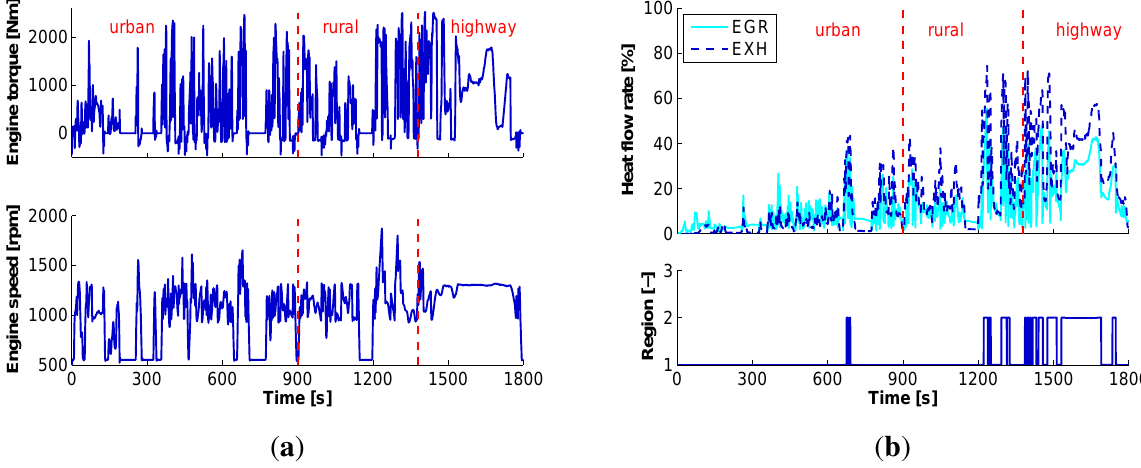
Figure 9. ( a ) Engine torque and speed from a cold-start World Harmonized Transient Cycle (WHTC); ( b ) Engine heat flow rate from a cold-start WHTC and operating region